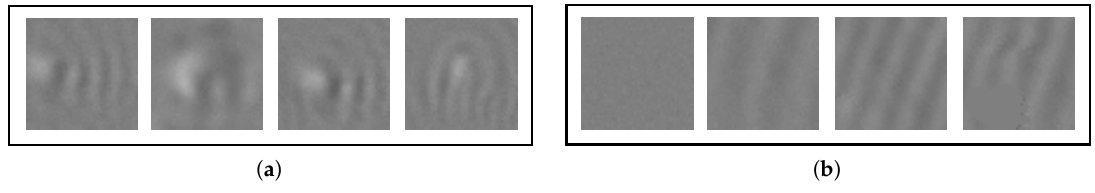
Figure 1. Images of positive samples in ( a ) and negative samples in ( b